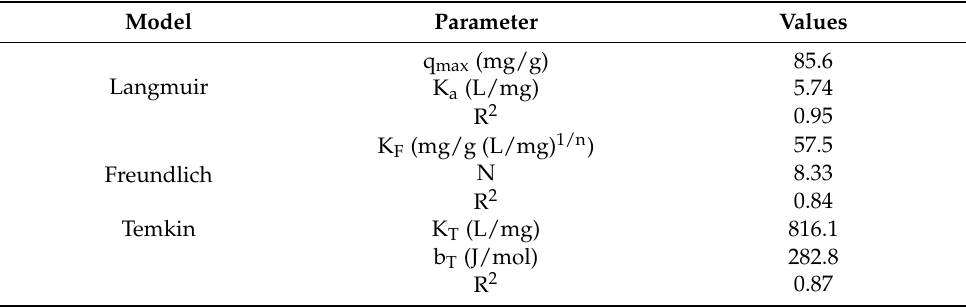
Table 7. Isotherm parameters and correlation coefficient of different